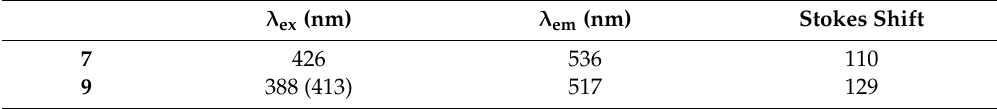
Table 1. Excitation and emission maxima and Stokes shifts for BAP substrate 9 and fluorophore 7